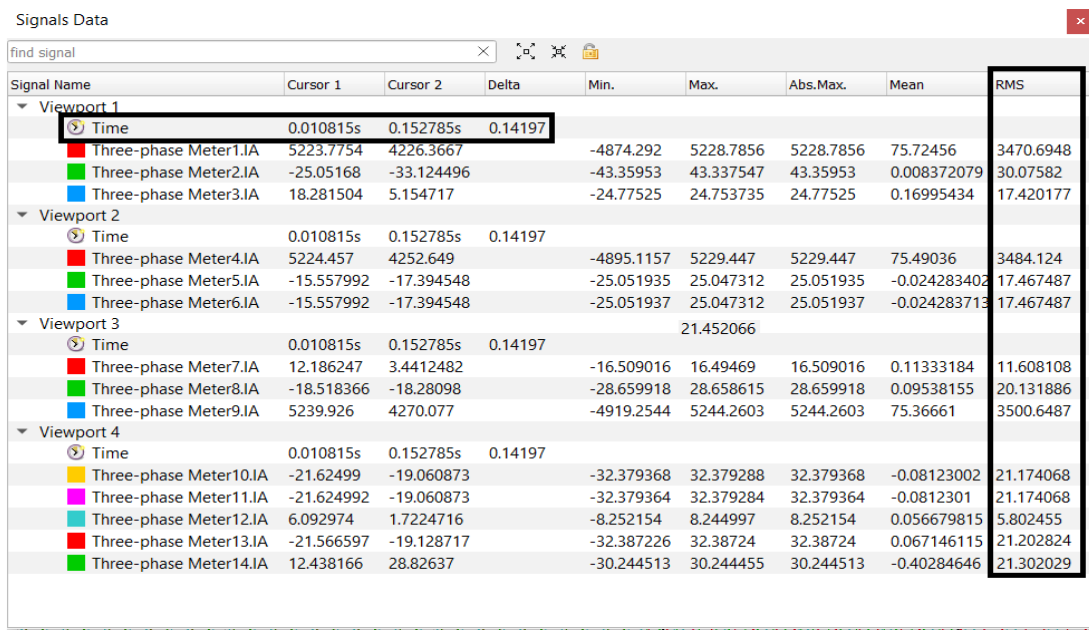
Figure 9. A 3LG fault at bus 9 in grid-connected mode.